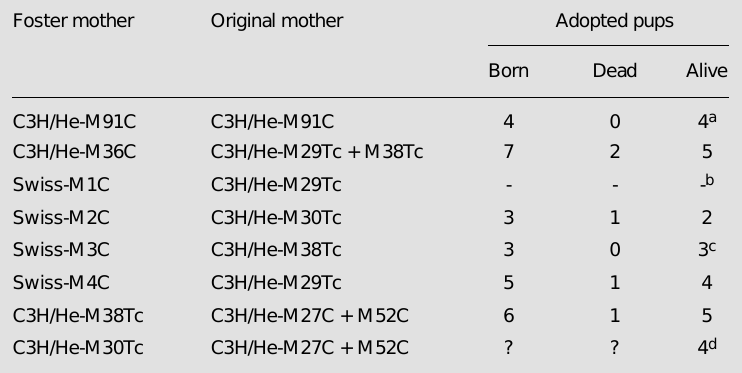
Table 1 - Experimental results obtained using the fostering cage and T. cruzi -infected (Tc) or non-infected (C) C3H/He females or non-infected Swiss females (C). a Experiment done in order to determine the ideal mesh dimensions. The pups were returned to their original mother; b the original mother was greatly stressed trying to pass through the mesh and was returned to her pups; c the foster mother was very aggressive and bit the original mother’s foot; d the delivery was not